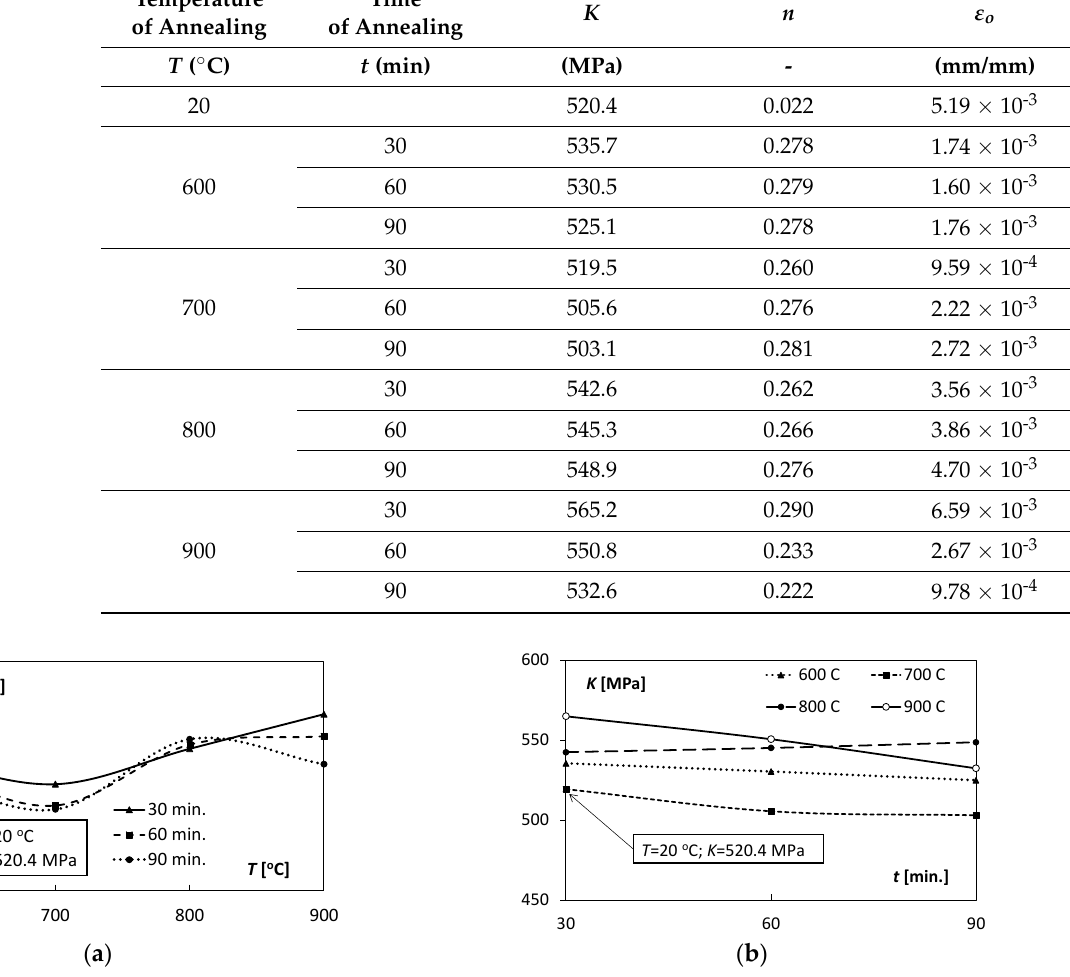
Figure 10. Dependence of the hardening coefficient K on: ( a ) annealing temperature T , ( b ) holding time t .